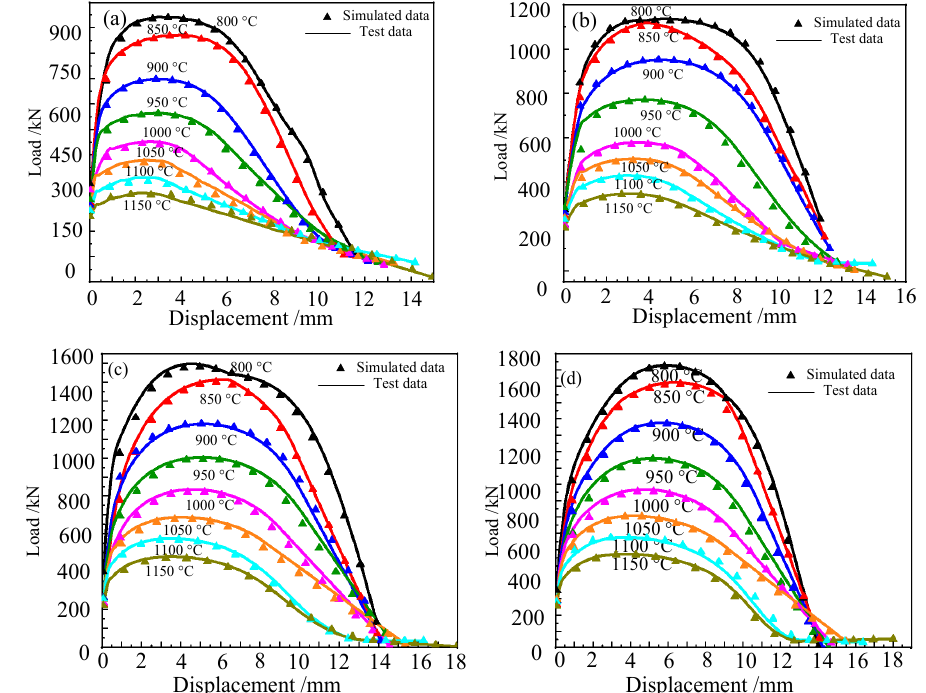
Figure 10. Comparison of displacement–load curves between the simulated tensile test and actual tensile test of Cr5 alloy steel: ( a ) 𝜀(cid:4662) = 0.01 s − 1 ; ( b ) 𝜀(cid:4662) = 0.1 s − 1 ; ( c ) 𝜀(cid:4662) = 1 s − 1 ; ( d ) 𝜀(cid:4662) = 5 s − 1 .